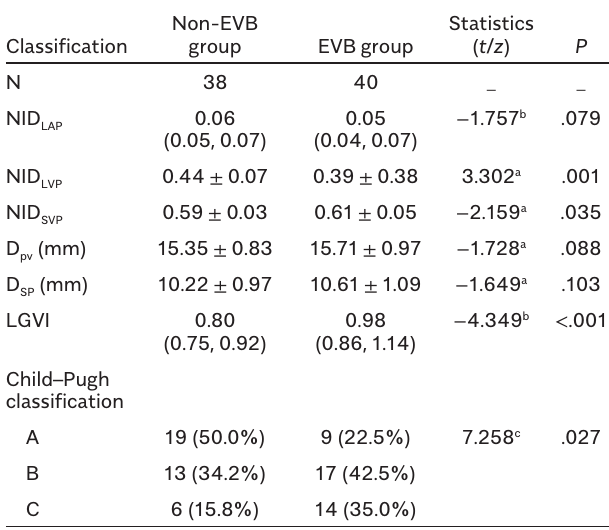
Table 4. Comparison of Spectral CT Parameters between the 2